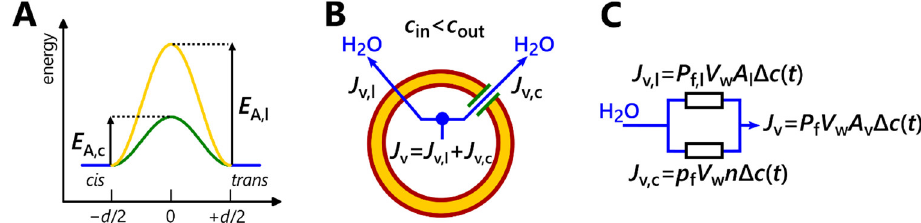
Figure 1. ( A ) The activation energy of transmembrane water transport through water-conducting channels, E A,c , is lower than that of non-facilitated permeation through the lipid bilayer, E A,l . E A,c is related to unitary channel permeability, p f , whereby p f ∝ exp(− E A /R T ) [8,9]. ( B ) In stopped-flow water flux measurements, lipid vesicles are exposed to hyperosmotic conditions by increasing external osmolarity, c out . Consequently, water exits the vesicle, whereby the volume flux of water, J v , is assessed by measuring the rate of change of intravesicular volume, d V ( t )/d t . Since V changes with time, so does internal osmolarity, c in ( t ), and thus, the osmotic gradient Δ c ( t ) = c in ( t ) − c out . Water can either traverse the lipid bilayer, J v,l , or permeate through membrane-embedded water-conducting channels, J v,c , as indicated by the blue arrows. Since both pathways are available independently, J v = J v,l + J v,c . ( C ) An equivalent circuit may illustrate the same: the resistances of the lipid bilayer (1/ P f,l ) and that of n channels (1/ P f,c ) add up, as detailed in Section 2.1. J v,l depends on the vesicle surface area covered by lipids, A l , over which water can permeate. Here, we consider experiments in which the area fraction covered by channels is negligible, i.e., the surface area of the vesicle A v is not significantly different from A l